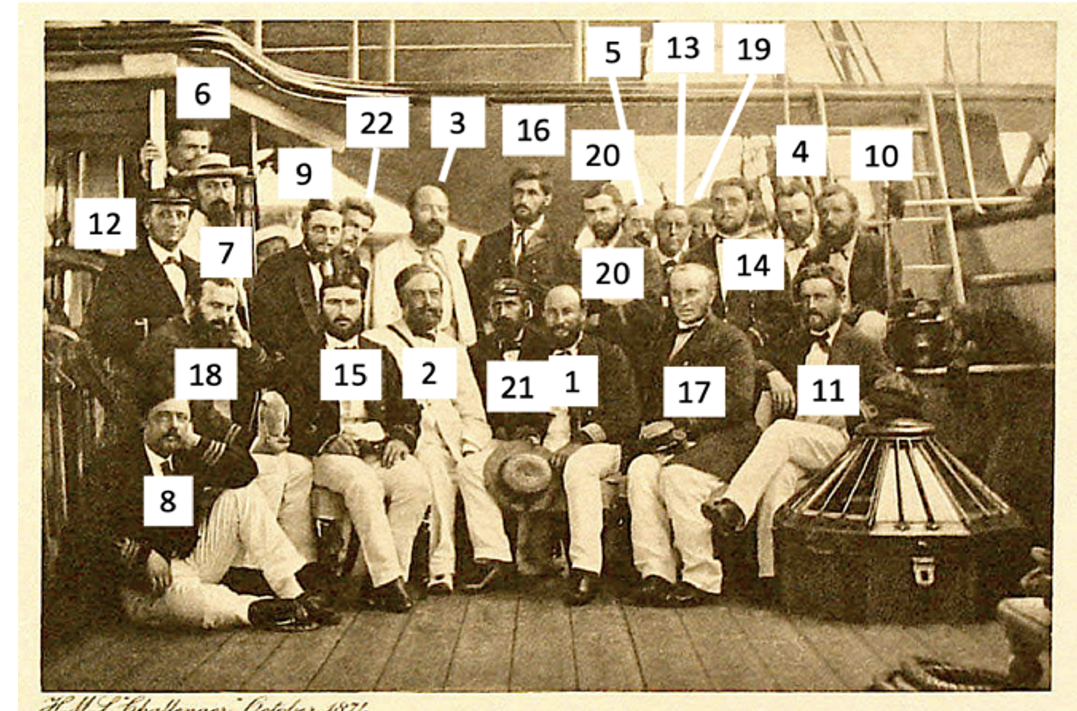
Figure 4. A group photograph of the Challenger ’s officers and scientists (courtesy of the archives of the Natural History Museum). Though they were unidentified in the Challenger reports they were identified by Rice (1986) as follows: (1) Nares, (2) Wyville Thomson, (3) Wild, (4) Murray, (5) Moseley, (6) Willemoes-Suhm, (7) Buchanan, (8) Cdr. Maclear, (9) Lt. Aldrich. (10) Lt. Bromley. (11) Lt. Bethel, (12)